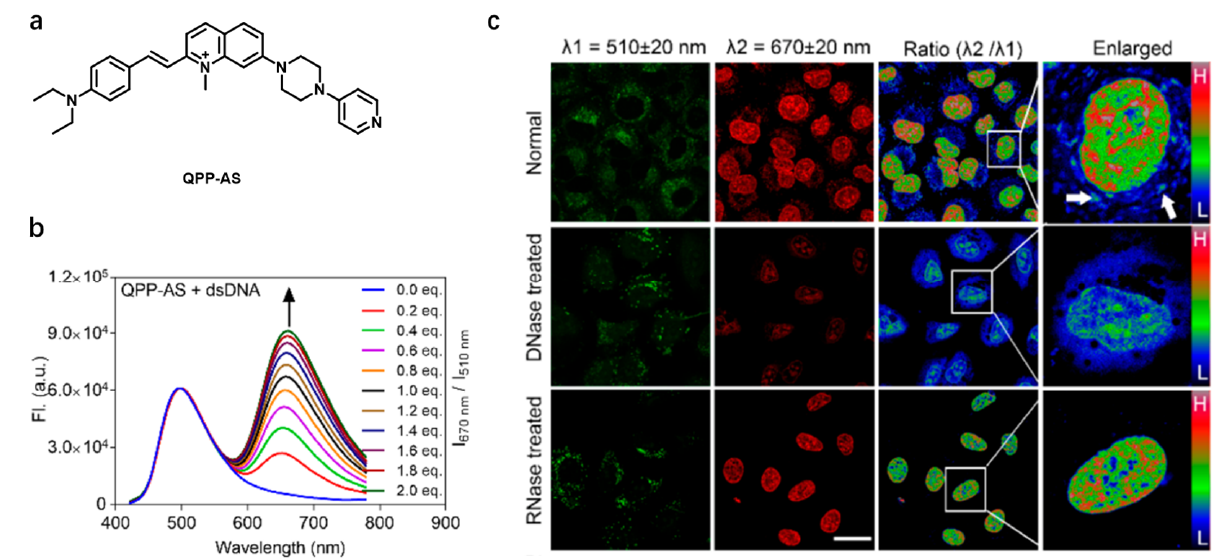
Figure 13. ( a ) The chemical structure of QPP-AS. ( b ) Fluorescence response of QPP-AS (3 µ M) to dsDNA in buffer solution. ( c ) Ratiometric fluorescence imaging of QPP-AS (10 µ M, incubated 2 h) by a dual-emission channel ( λ 1 = 510 ± 20 nm; λ 2 = 670 ± 20 nm; ratio = λ 2 / λ 1 ) at λ ex = 405 nm in living A549 cells, fixed A549 cells with DNase I (100 U/mL,2 h) treatment, and RNase A (100 µ g/mL, 2 h) treatment. Reproduced from [50] with permission from the American Chemical Society, Copyright 2021.